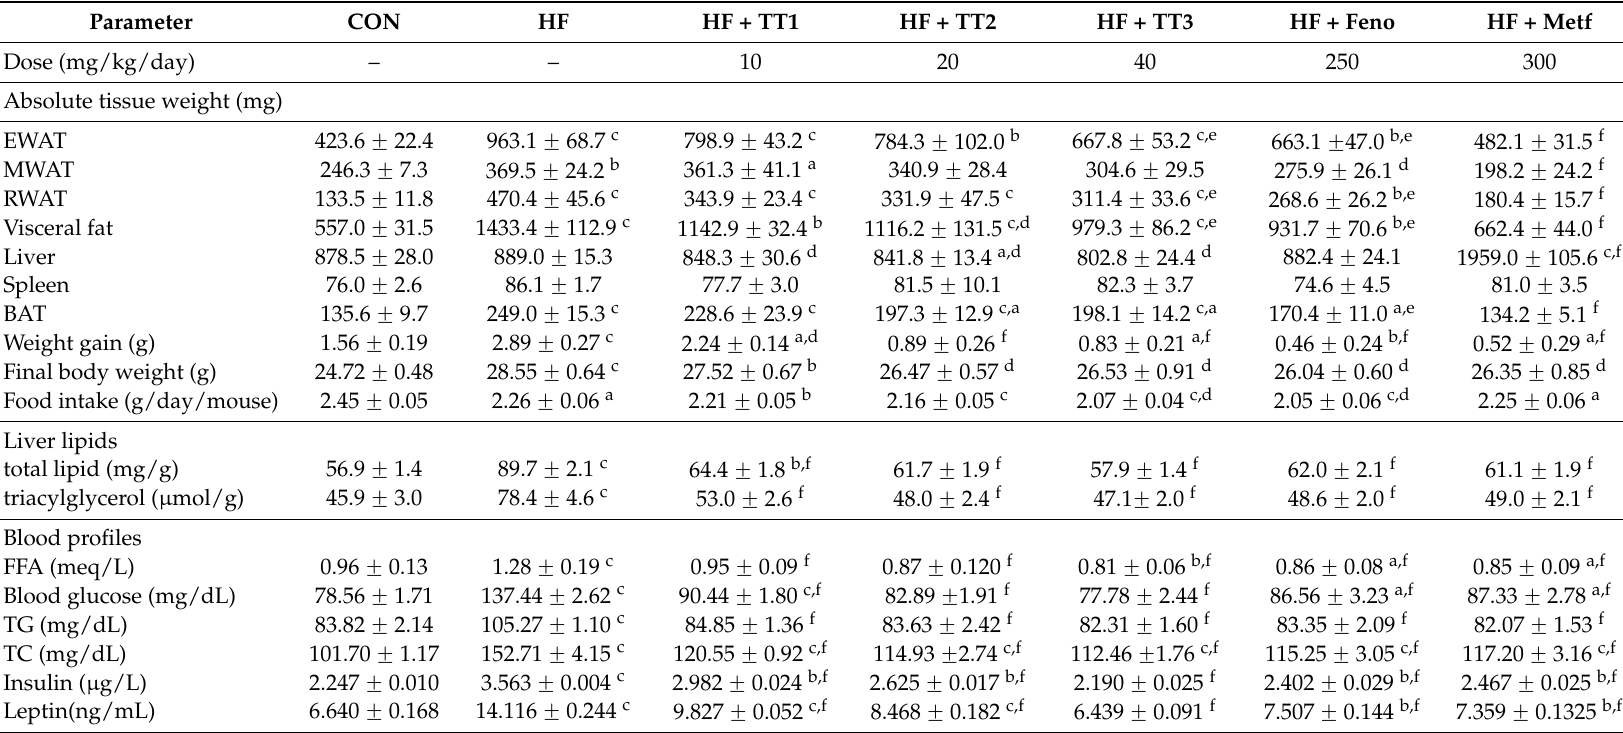
Table 1. Effects of dehydroeburicoic acid (TT) on absolute tissue weight (mg), food intake, and blood parameters in HFD-fed mice. All values are means ˘ SE ( n =